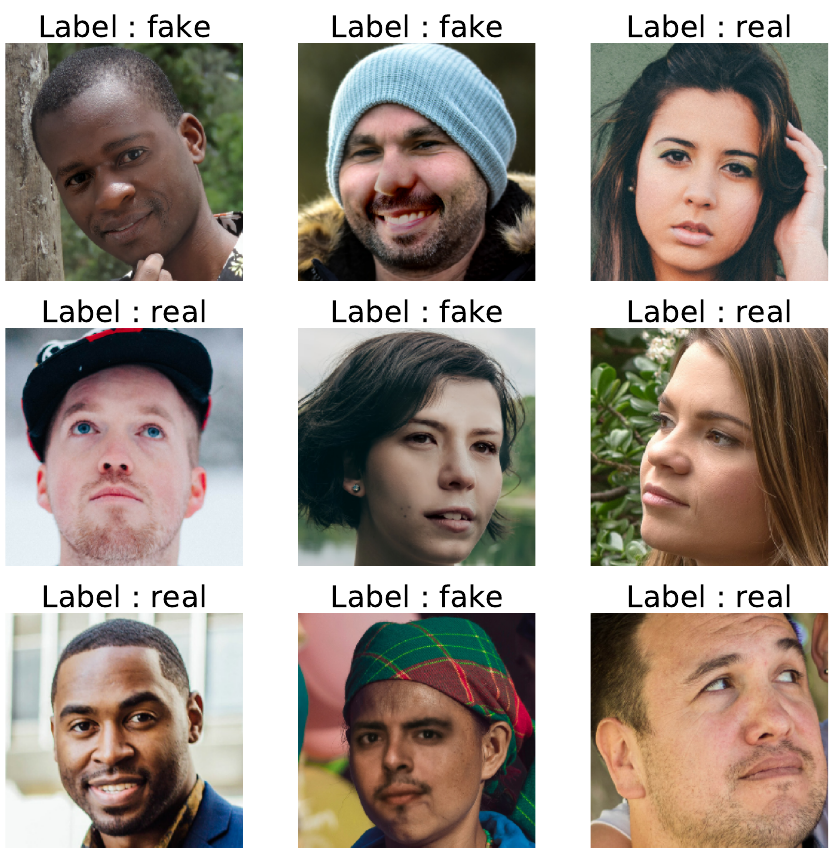
Figure 2. The deepfake dataset sample image analysis with the assigned